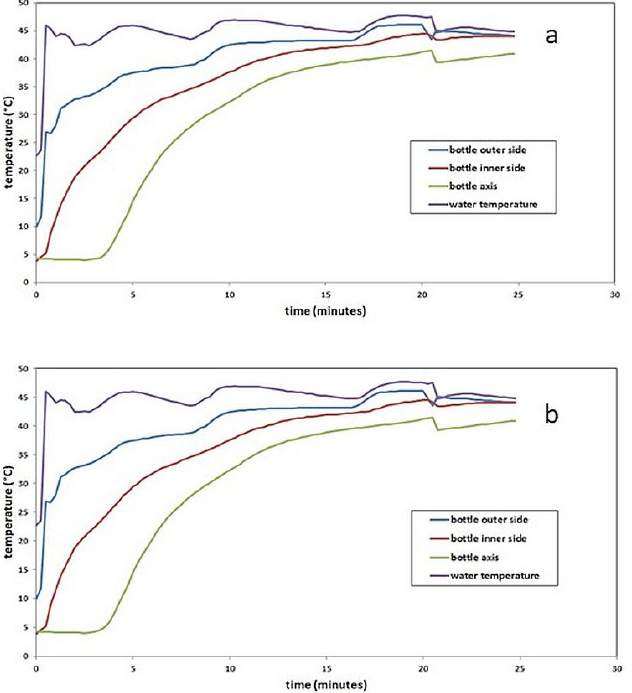
Figure 6. The temperature history of thawed PBM during warming of bottle No. 2 ( a ) and No. 4 ( b ).